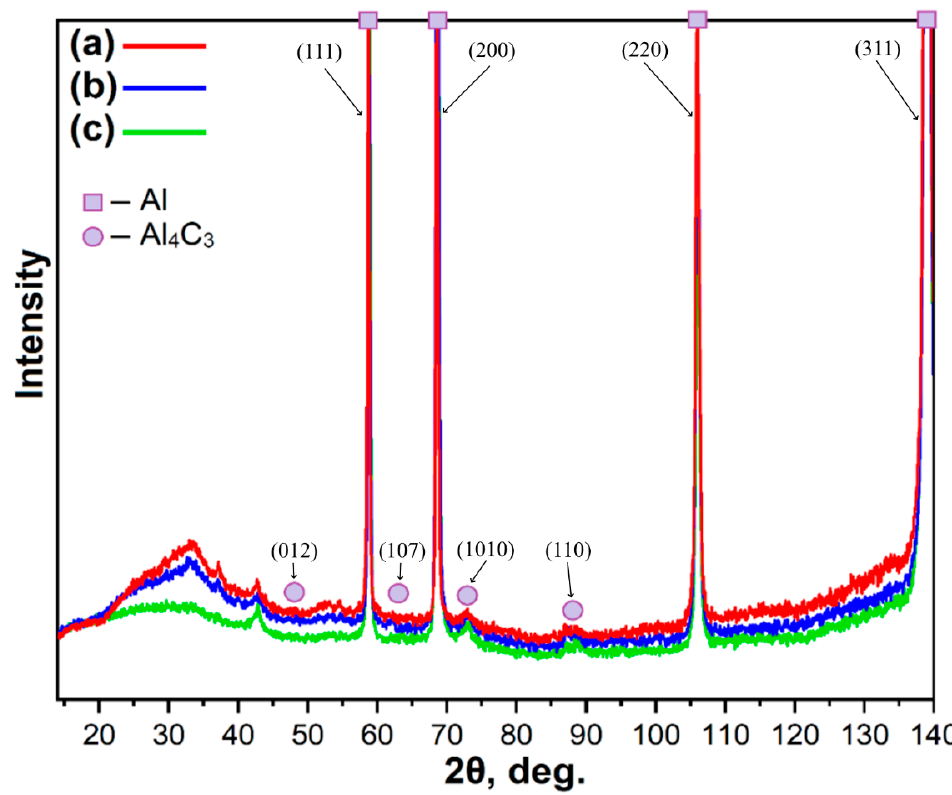
Figure 7. SLM printed Al–C composite samples: ( a – c ) lines represent the XRD spectrum of synthe- sized Al–C samples 2, 4, 8.